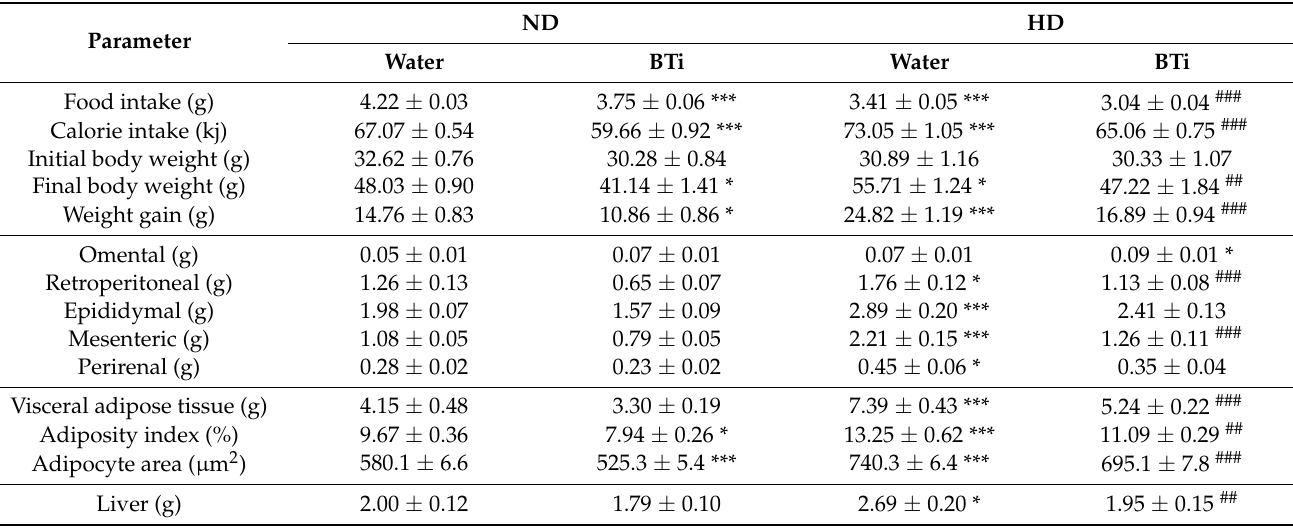
Table 2. Effect of the BTi on food and caloric daily intake, weight gain, liver and fat pad weights, adiposity index and adipocyte